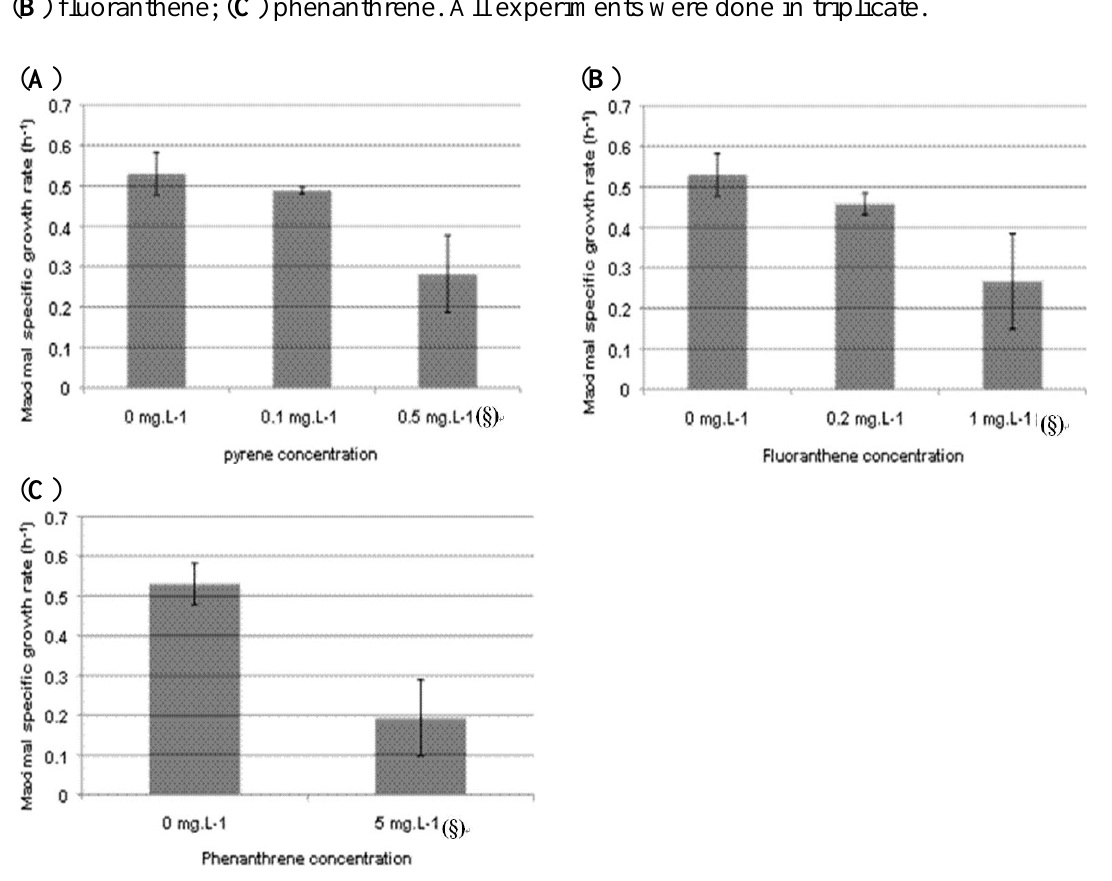
Figure 4. Effect of PAH concentration on maximal specific growth rate of P. fluorescens DSS73 in DMB. (§: PAH concentration higher than its solubility limit). ( A )